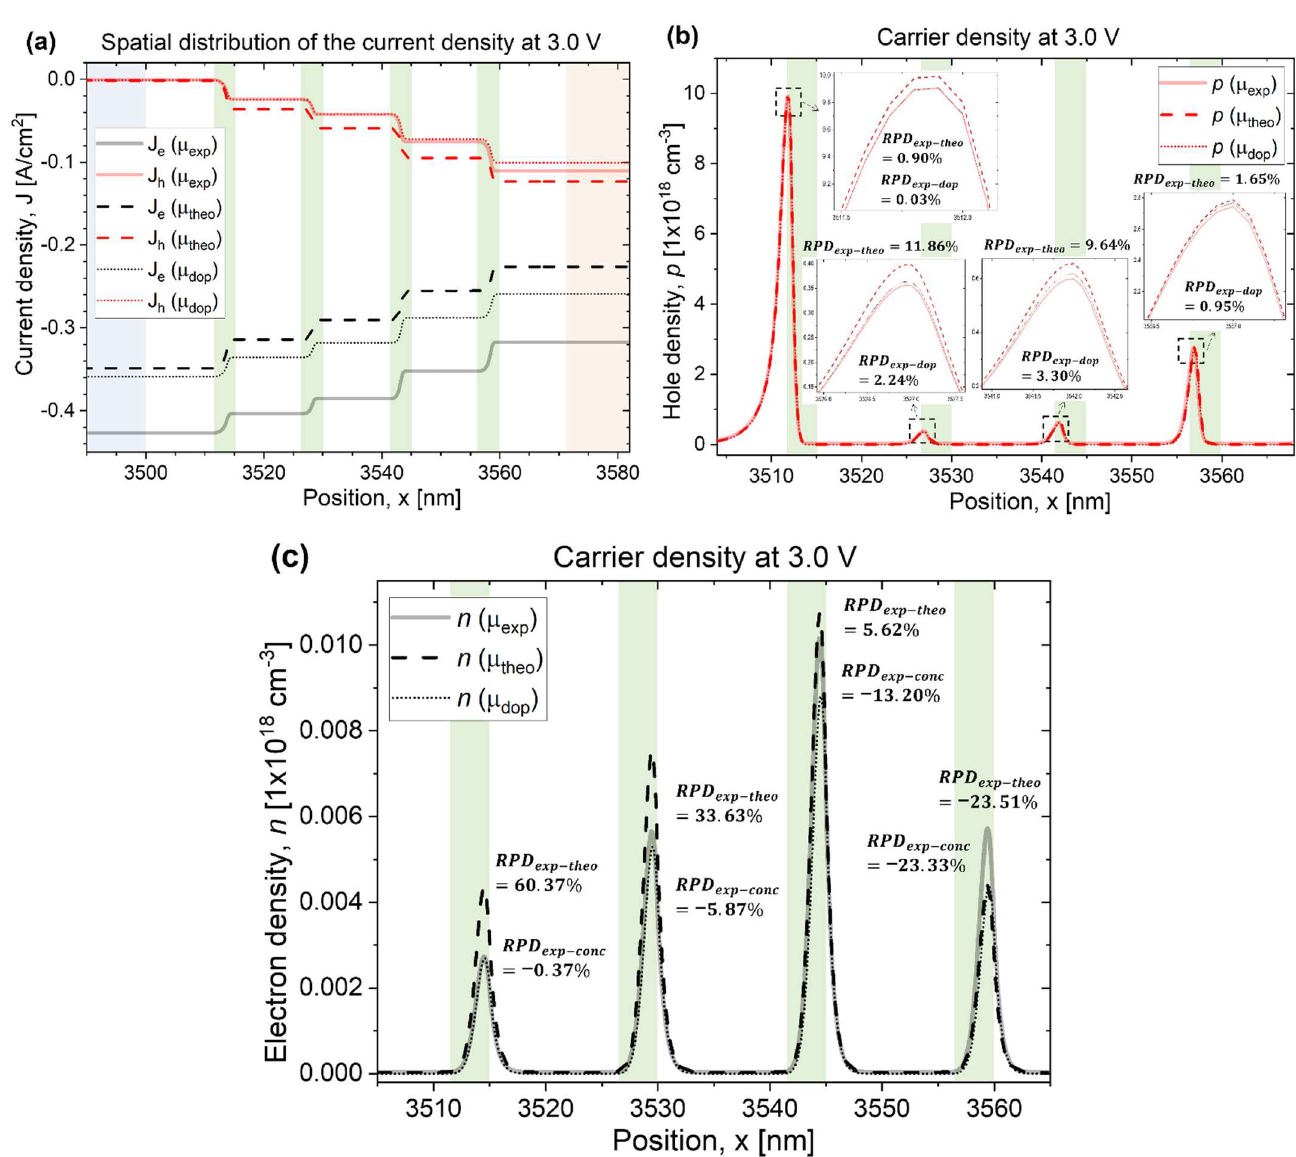
Figure 6. ( a ) Spatial distribution of current density, ( b ) hole, and ( c ) electron density in the active layer of the LED at 3.0 Volts.